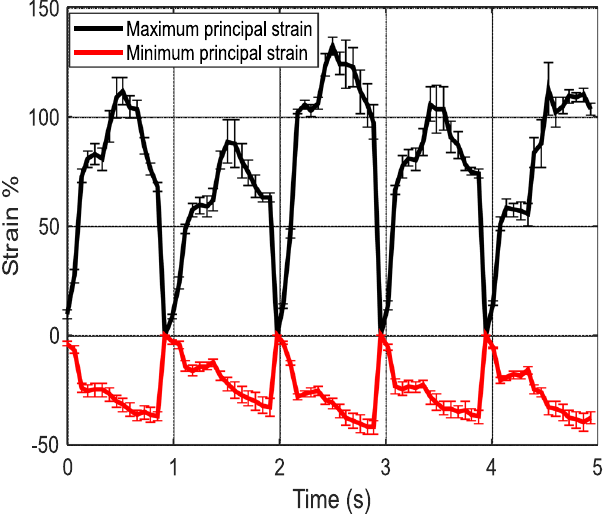
Figure 5. Average maximum and minimum principal strains obtained from the DIC analysis and the standard deviation error bars for each point.